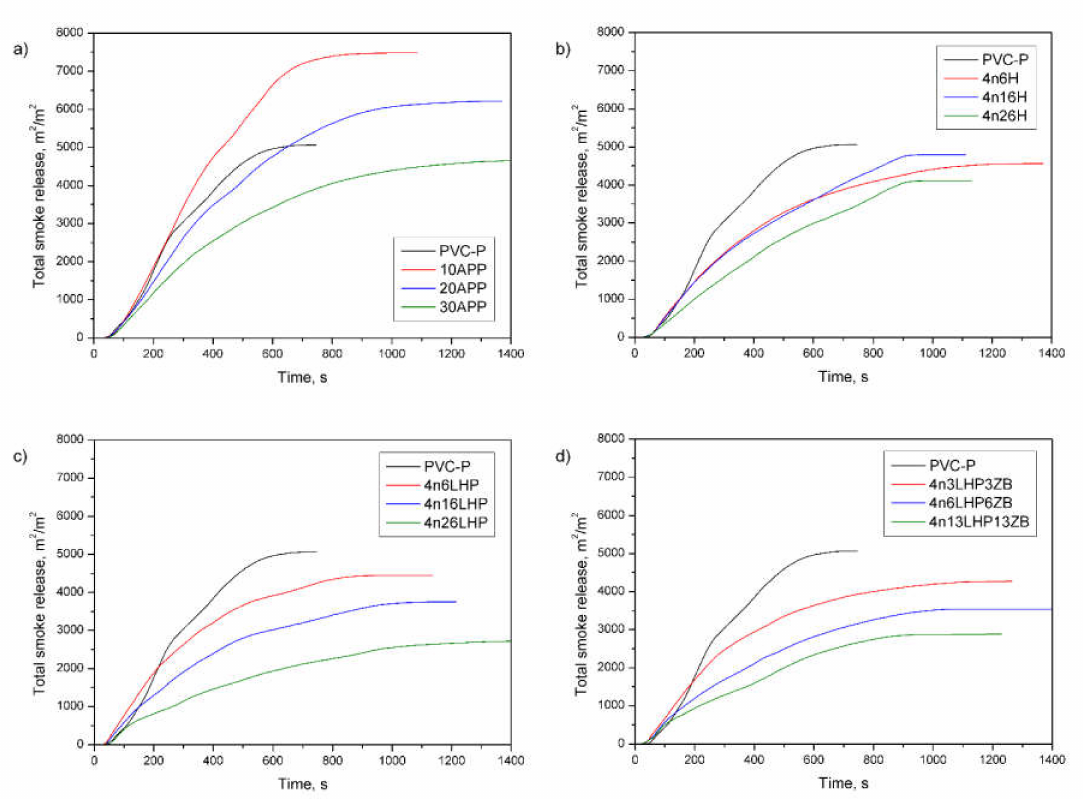
Figure 11. Representative curves of total smoke release of the PVC-P and PVC-P with APP ( a ) or n/H ( b ), n/LHP ( c ), and n/LHP/ZB ( d )